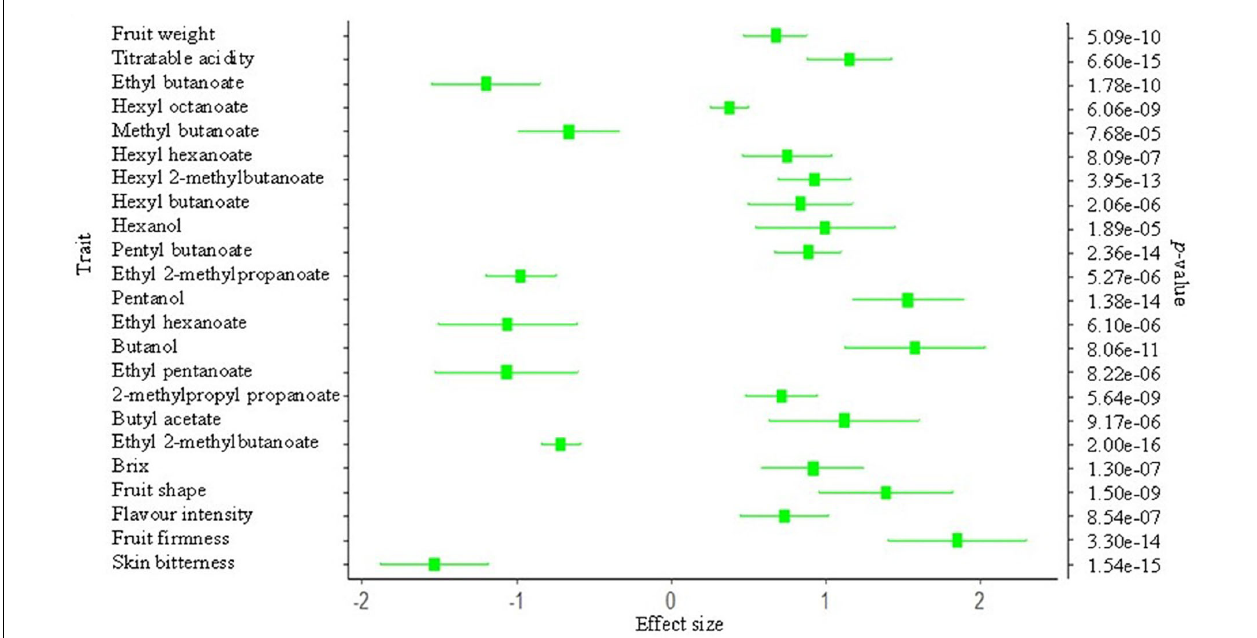
FIGURE 4 | Effect of inbreeding (F ROH )/selection on various pear ( Pyrus spp.) phenotypes. The x-axis represents the effect size (in phenotypic standard deviation unit) estimate of F ROH = 0.15. The secondary y -axis shows the probability of significance of the effect size for traits that reached Bonferroni-corrected significance of probability value (=0.01/32